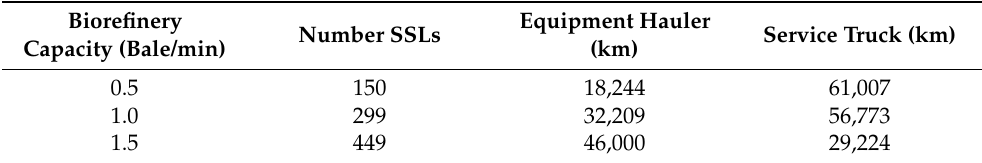
Table 4. Distance traveled to support SSL load-out operations.